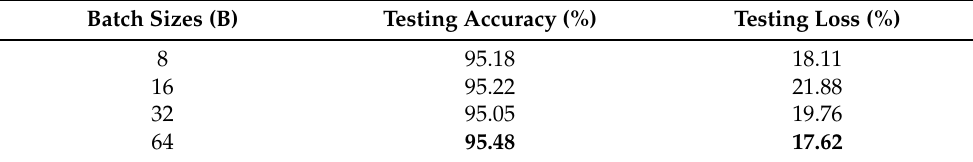
Table 6. Testing accuracy and loss of different batch sizes (O = SGDM, M = concat).